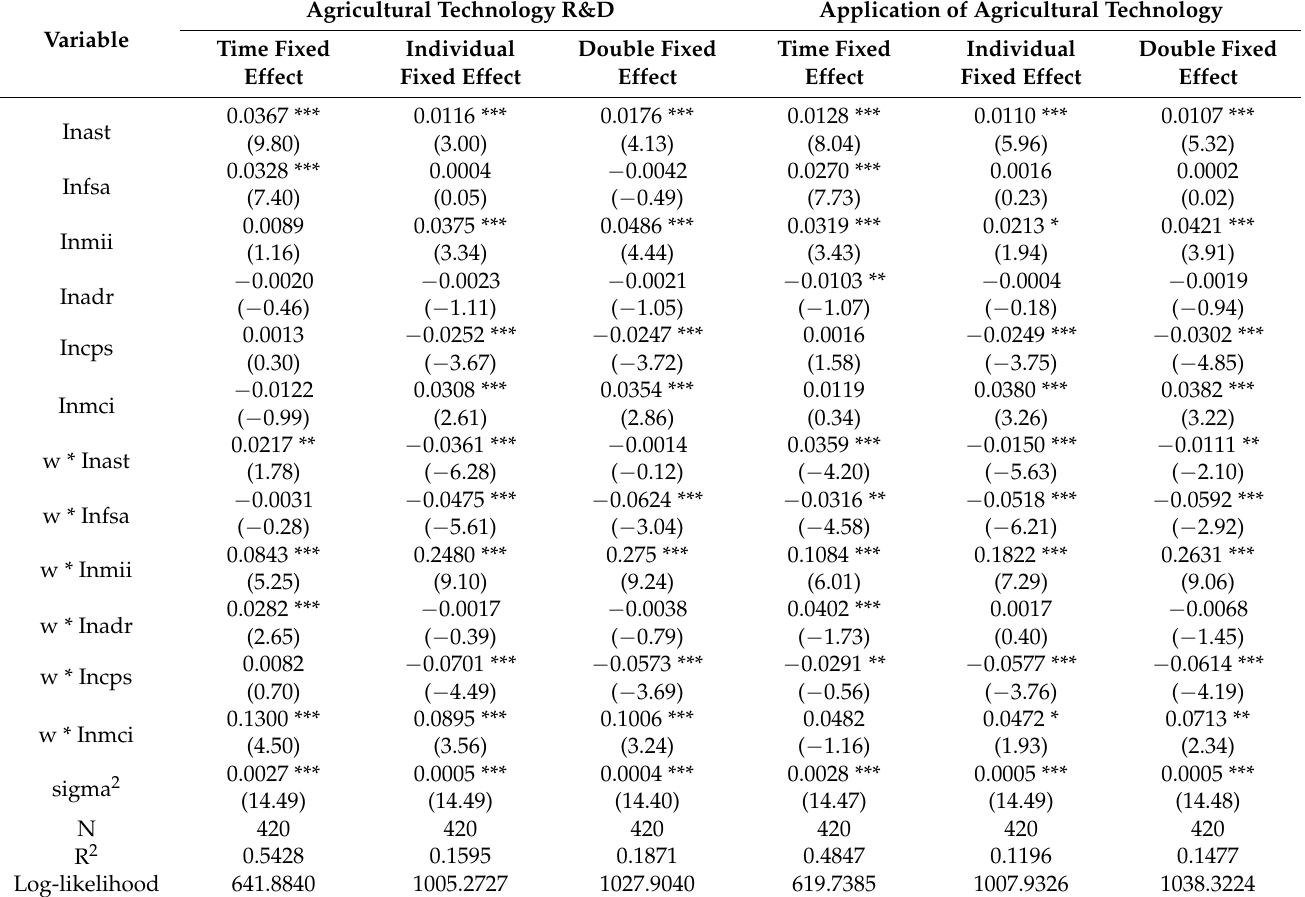
Table 11. Spatial panel econometric regression results of agricultural science and technology innova- tion on green agricultural development under the economic matrix.